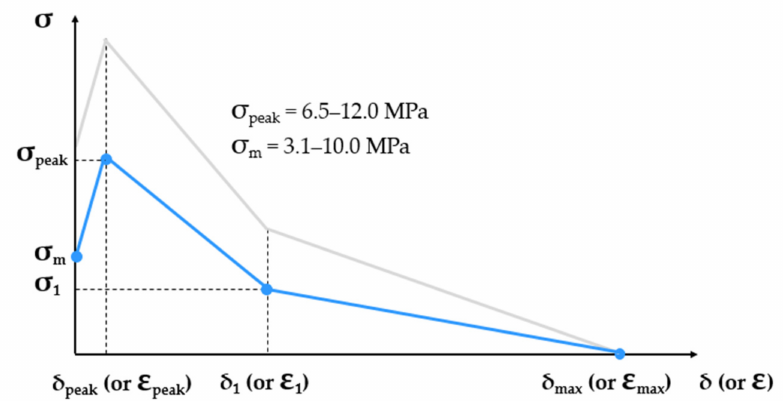
Figure 2. Qualitative representation of the post-elastic constitutive law of SHCC in tension including the varying matrix strength and tensile strength within predefined ranges.